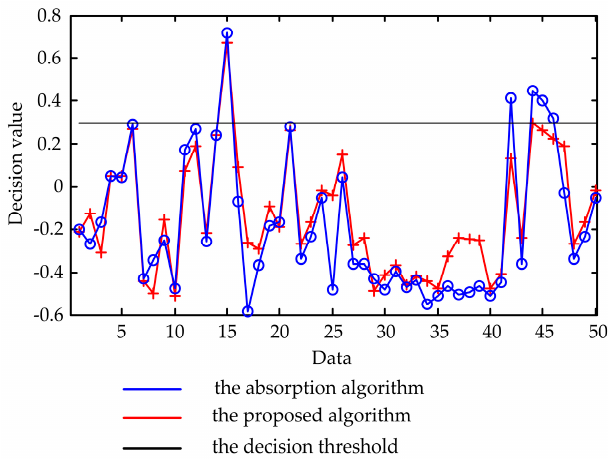
Figure 14. Comparison of the misdiagnosis rate of our proposed fusion algorithm and the absorption algorithm.